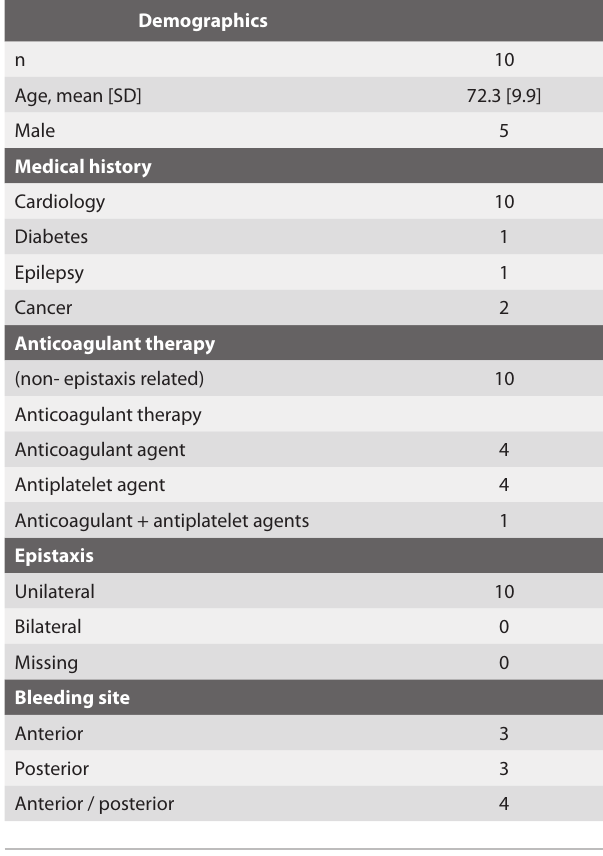
Table 1. Demographics and baseline